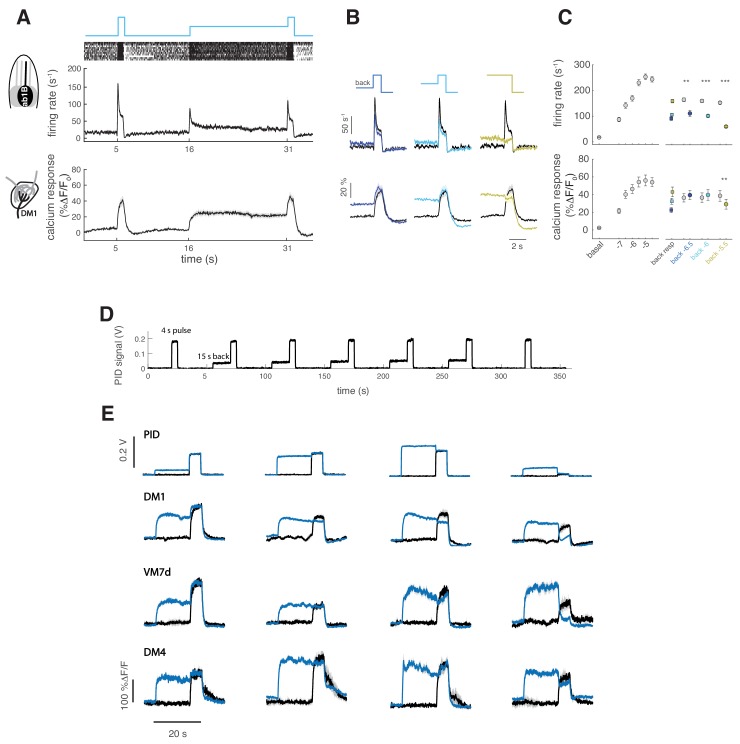
ORN background adaptation.(A) Top: a pulse of methyl acetate (10−5 dilution) was presented first isolated and on top of a background of the same odor at lower concentration (10-6.5) delivered for 15 s. Middle: raster plot and mean firing rate for the spiking response of ab2A (expressing OR59b) measured in single sensillum recordings, n = 12. Bottom: mean calcium response measured at the axon terminals in the corresponding glomerulus DM1, n = 10. Shaded areas and error bars indicate SEM. (B) Overlay of the response to the isolated odor pulse (black) and the pulse presented on top of the background (colored) for three increasing values of the background concentration, (n = 10–13 for firing rate and n = 9–10 for calcium imaging). (C) Left: Dose-response curve measured as mean firing rate (n = 9–10) and mean calcium response (n = 11) for increasing concentrations of the isolated odor pulse. Right: Mean response to the different odor backgrounds (squares), to the isolated pulse (gray circles) and to the pulse on top of the background (colored circles). Paired t test, *p<0.05, **p<0.01, ***p<0.001, n = 10–13 for firing rate and n = 9–10 for calcium responses. (D) PID measurements of the stimulus sequence used for experiments with GCaMP6f. A control pulse was delivered at the beginning and at the end of the stimulus sequence. The same pulse was then presented on a background of the same odor after 15 s presentation of the odor. The test was presented five times and the stimulus was reproducible over repetitions. Odor: Methyl acetate, pulse duration is 4 s (in main Figure 3 the test pulse is 1 s). (e) Mean calcium response from single flies expressing GCaMP6f in ORNs, averaged over five repetitions in presence and absence of the background odor for different values of the background and pulse concentration, as reported by PID measurements. Results are consistent with those reported by GCaMP3 (Figure 3).